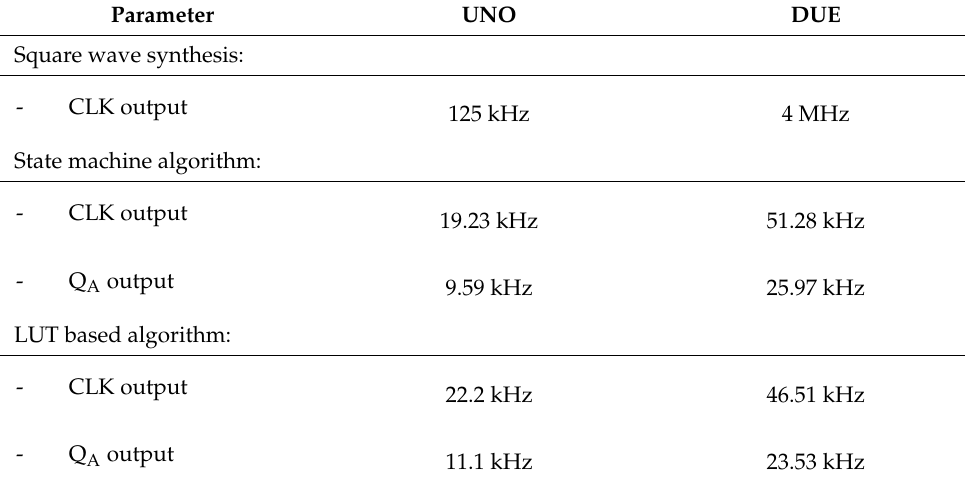
Table 1. Digital synthesis: maximum output frequency according to the type of platform.